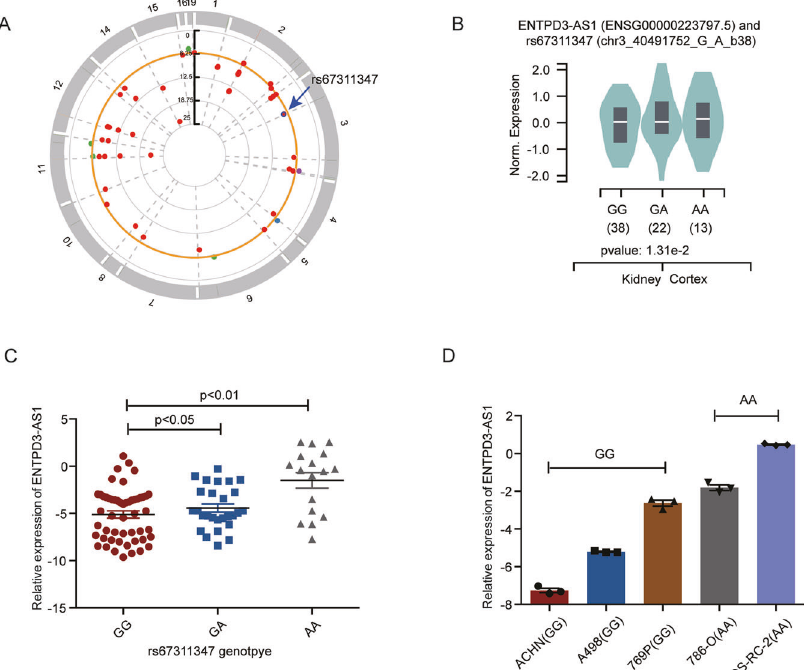
Fig. 1 RCC-associated SNP rs67311347 regulated the expression of ENPTD3-AS1. A The Manhattan Plot of RCC-associated SNPs in GWAS. B eQTL analysis of rs67311347 using data from the GTEx Project. C The expression of ENPTD3-AS1 in normal kidney tissues with different genotypes of SNP rs67311347 in Cohort 1. D The expression of ENPTD3-AS1 in RCC cell lines with different genotypes of SNP